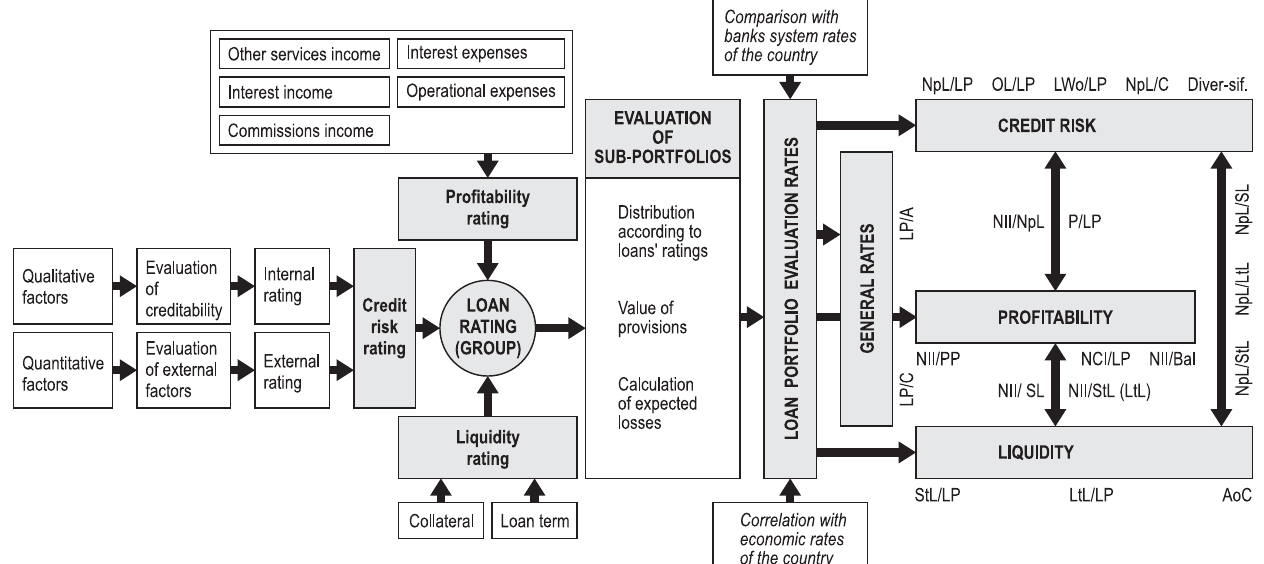
Fig. 1. The structure of the evaluation model of a commercial bank loan